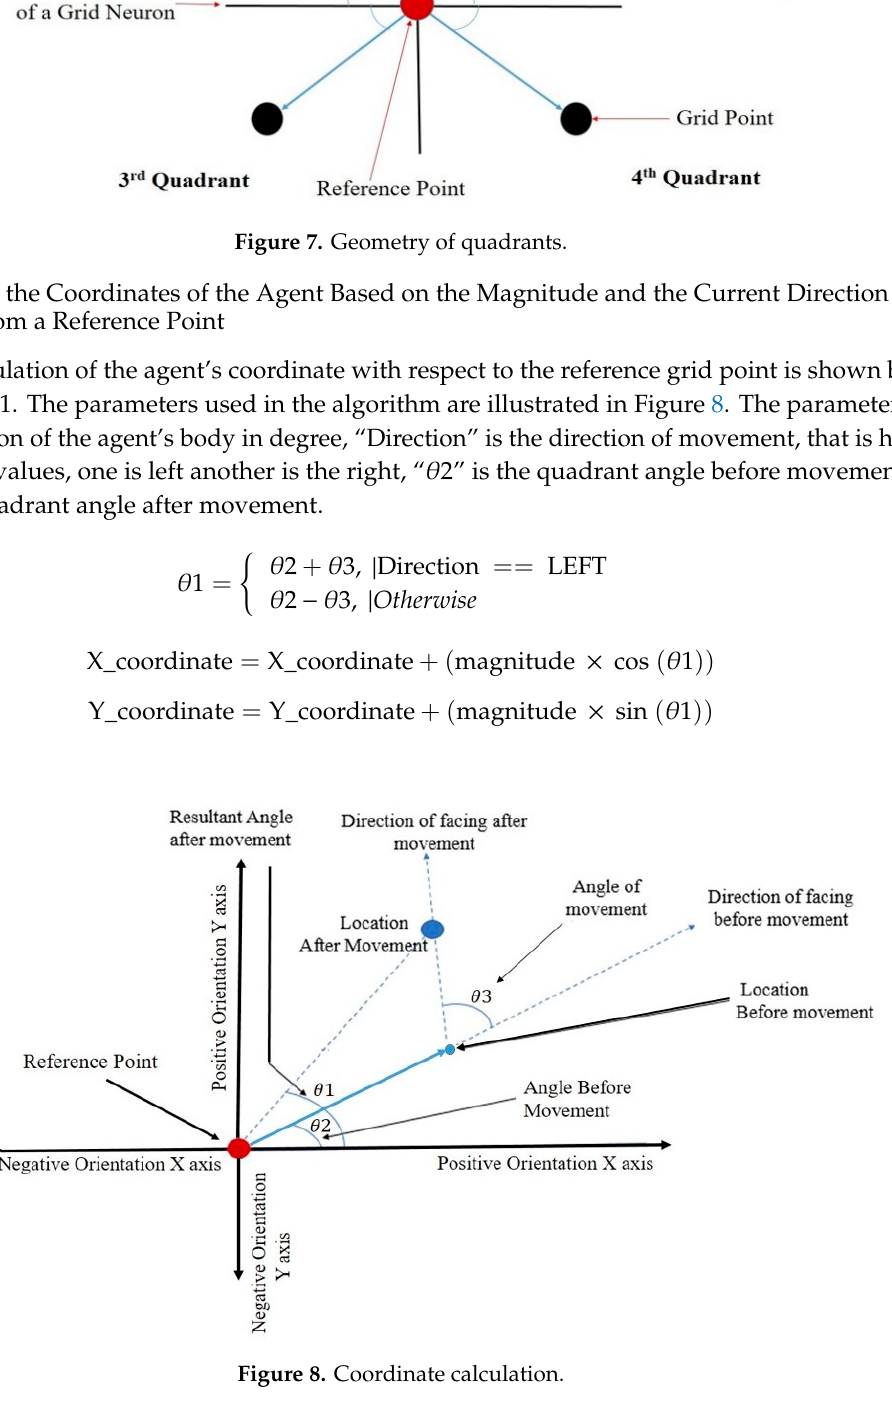
Figure 8. Coordinate calculation.